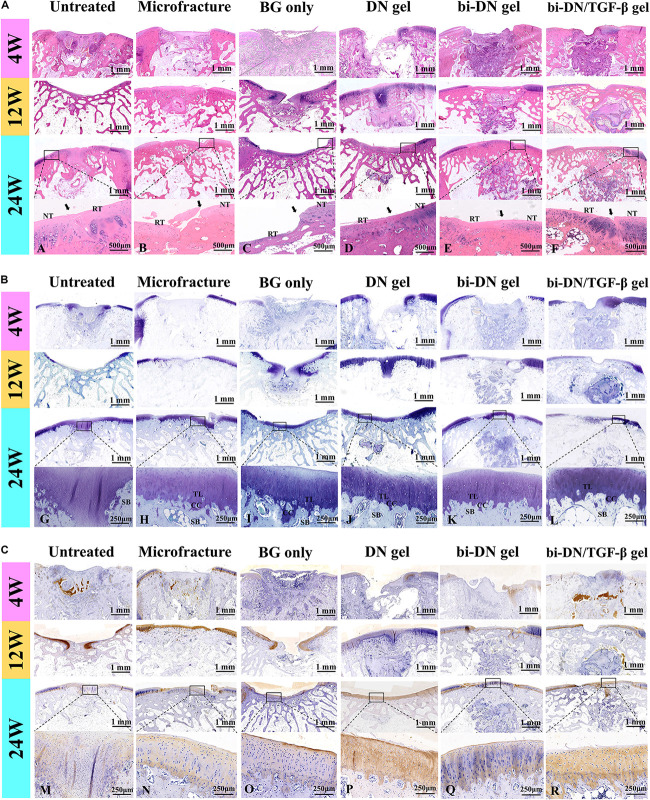
Histological evaluation of new cartilage and subchondral bone formation at 4, 12, and 24 weeks after surgery (NT, normal tissue; RT, repaired tissue; TL, tideline; CC, calcified cartilage; SB, subchondral bone; the arrows indicated the margins of the normal tissue and repaired tissue). H&E staining (A), Toluidine Blue staining (B), and Col II immunohistochemical staining (C) were integrally applied to recognize the cellular density, morphology, type and distribution, degradation of scaffolds, and to evaluate the structure, content and distribution of the glycosaminoglycans and Col II in the extracellular matrix (BG, bioactive glass; DN gel, GC/Alg double network hydrogel; bi-DN gel, double-layered DN gel). A–R indicated the enlarged observation of the corresponding region in the little box.